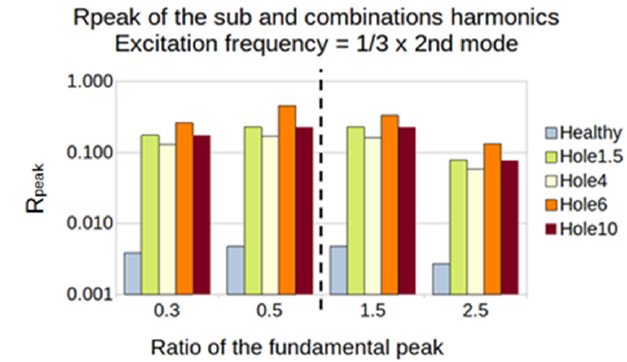
Figure 20. Second natural frequency and its ratio of 1, 1/2 and 1/3 as the frequency of excitation for the PVDF sensor.